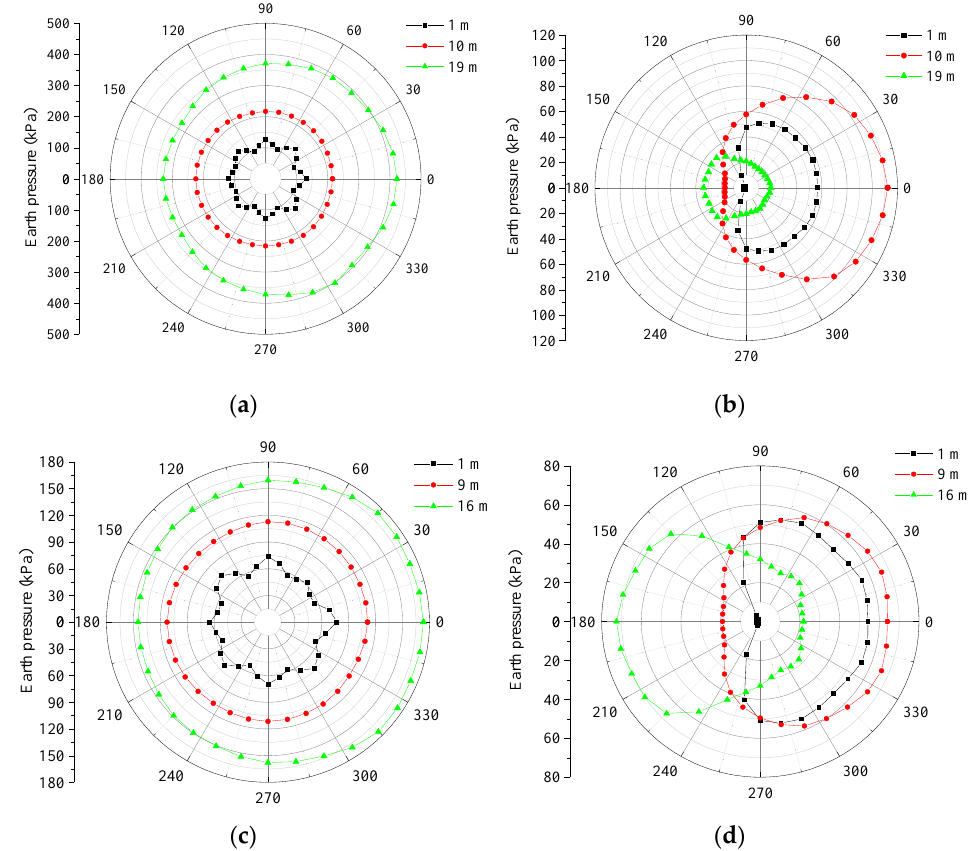
Figure 10. Circumferential distribution of earth pressure on the inside and outside skirt of 1# bucket of TSPJF and TBJF at different depths. ( a ) earth pressure on the inside skirt of 1# bucket of the TSPJF, ( b ) earth pressure on the outside skirt of 1# bucket of the TSPJF, ( c ) earth pressure on the inside skirt of 1# bucket of the TBJF, ( d ) earth pressure on the outside skirt of 1# bucket of the TBJF. 3. Comparison of Bearing Characteristics of TSPJF and TBJF under Horizontal Load Two loading directions are considered in the analysis of monotonic horizontal